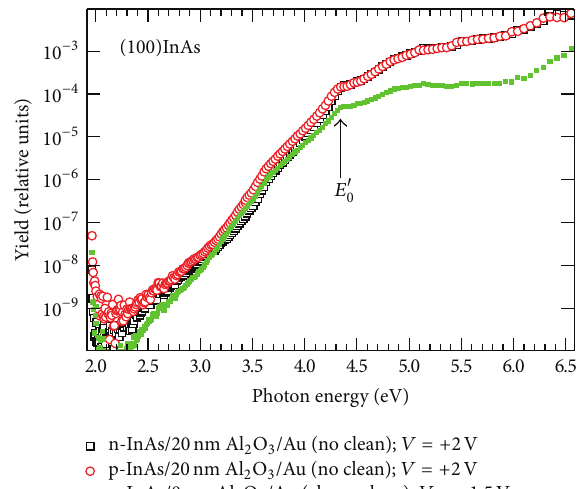
Figure 27: Semilogarithmic plot of the IPE quantum yield as a function of photon energy as measured on (100)InAs/a-Al 2 O 3 /Au samples prepared by using different alumina growth schemes. The vertical arrow 𝐸 󸀠 0 marks the energy of direct optical transitions in the InAs crystal.